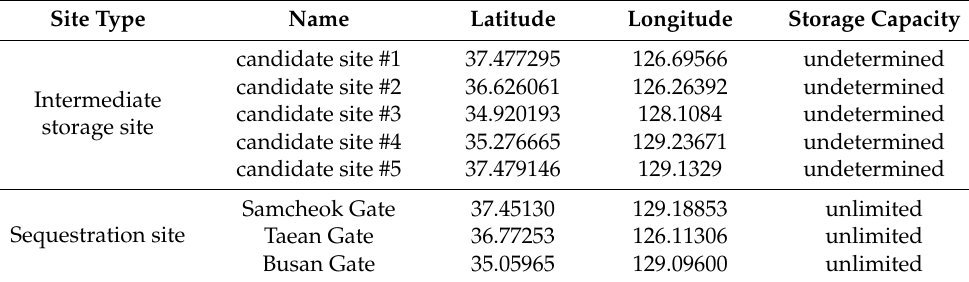
Table 2. Intermediate storage and sequestration site coordinates.